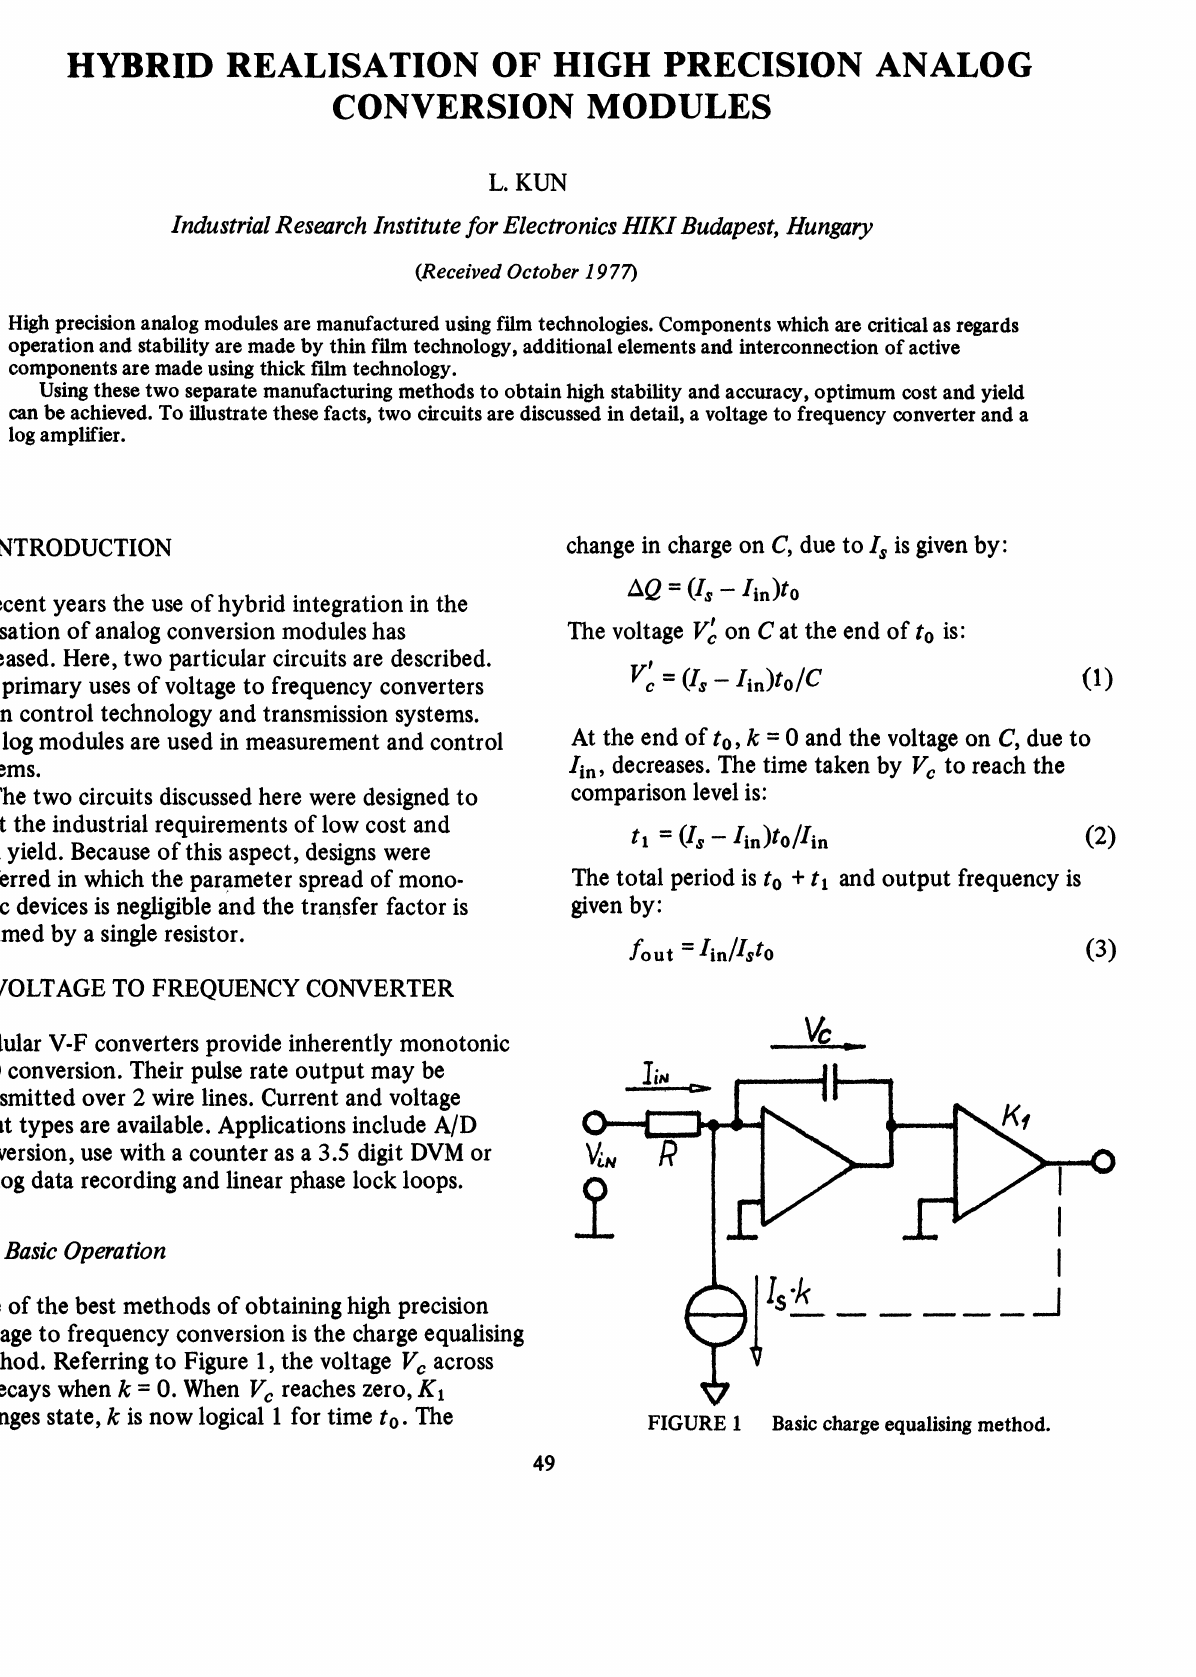
Basic charge equalising